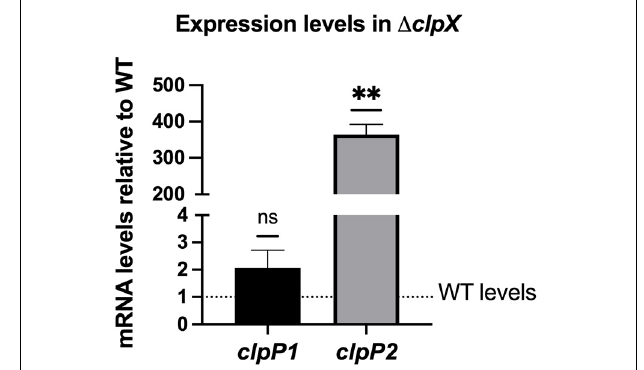
FIGURE 2 | B. anthracis clpP2 expression is regulated by ClpX. Expression levels of clpP1 and clpP2 in (cid:49) clpX B. anthracis Sterne are shown relative to expression in the wild-type (WT) strain (dotted line). Data are presented as mean ± SD from three independent RNA preparations. Statistical significance determined by a one-sample t -test; ** p < 0.01 or non-significant